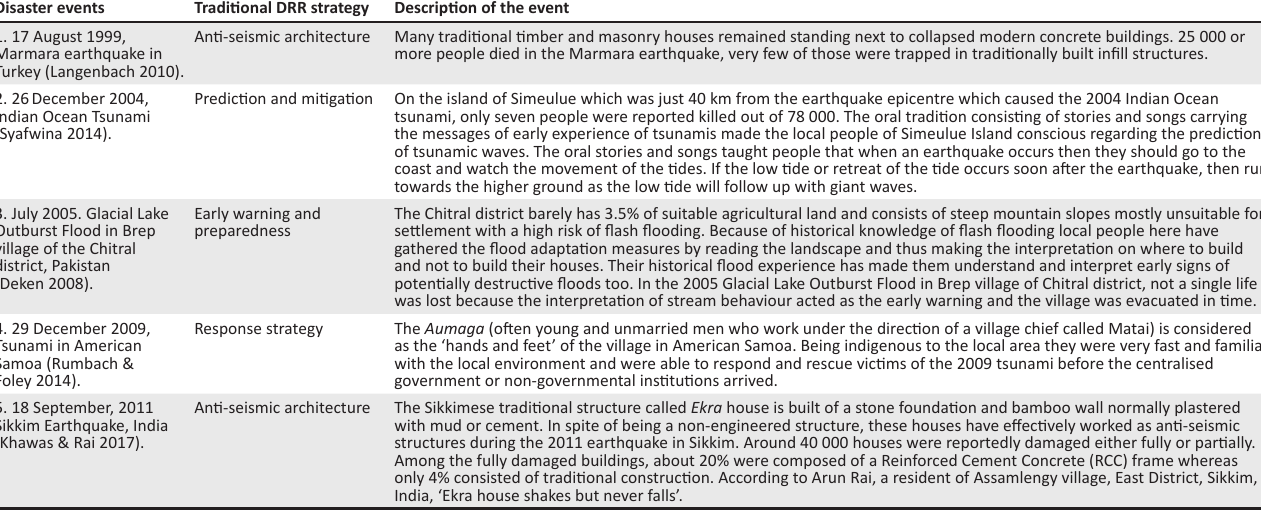
TABLE 2: Traditional knowledge in disaster risk reduction: Achievements from the world around.